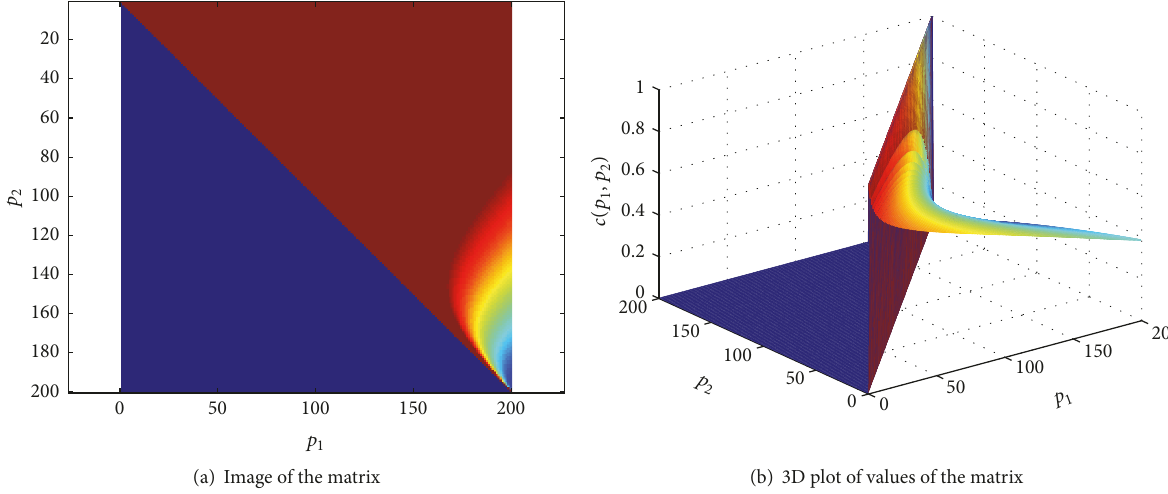
A [ ] (𝑘)] ] −1 A [−𝜇(𝑘)] . 𝑘 0 𝑘 𝑘 0